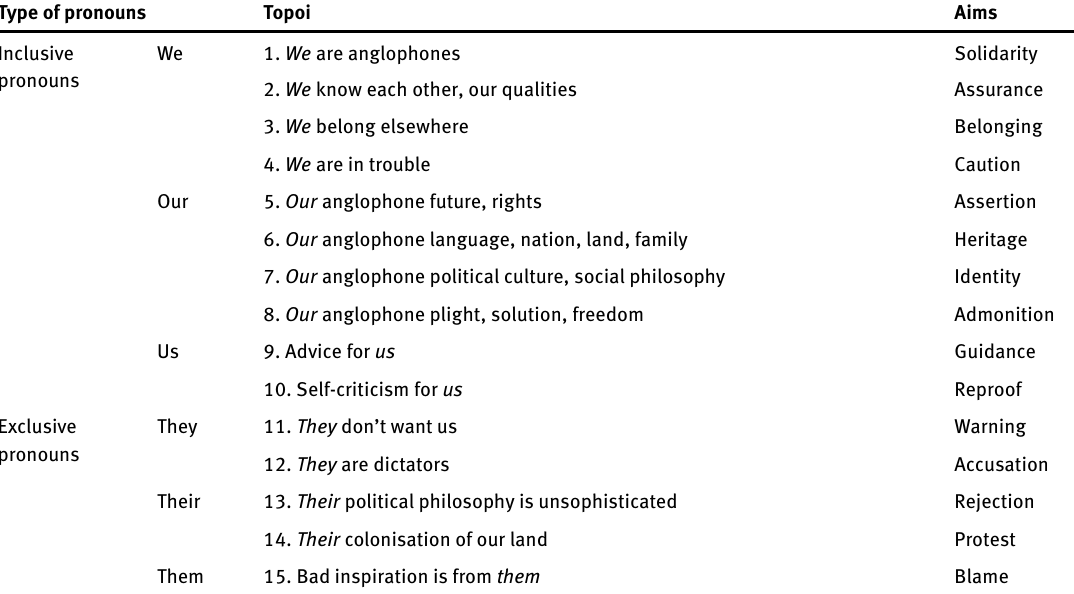
Table 1. Topoi in the use of pronouns Type of pronouns Topoi Inclusive